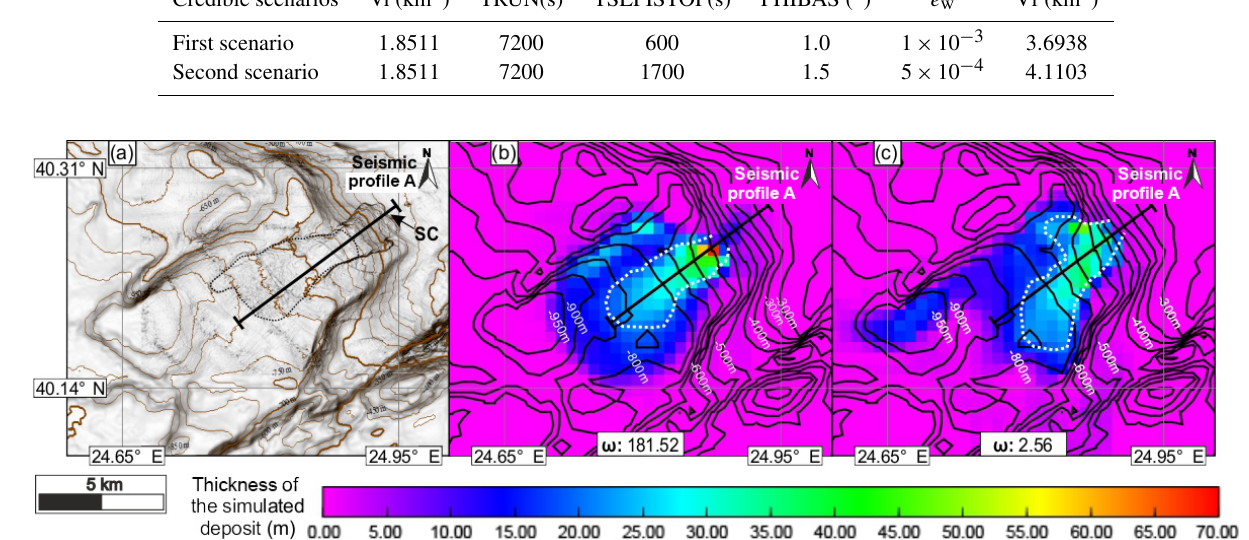
Figure 3. Numerical reconstruction of the final position of the slide for the two credible scenarios. (a) Multibeam bathymetry of the slide. Black dotted line corresponds to the limit of the slide deposit (in orange on Fig. 2). (b) The position of the slide’s deposit for the first credible scenario. White dotted line highlights the main transport deposit (above 20m thick). The resolution of the seismic profile is not enough to track a mass-transport deposit thinner than 20m. (c) The position of the slide’s deposit for the second credible scenario with the same convention as in (b) . ω is a coherence index. The higher this index is, the closer the simulation is to the observable data. This index is defined with normalized inverse-distance weighting (Appendix A). SC is slide